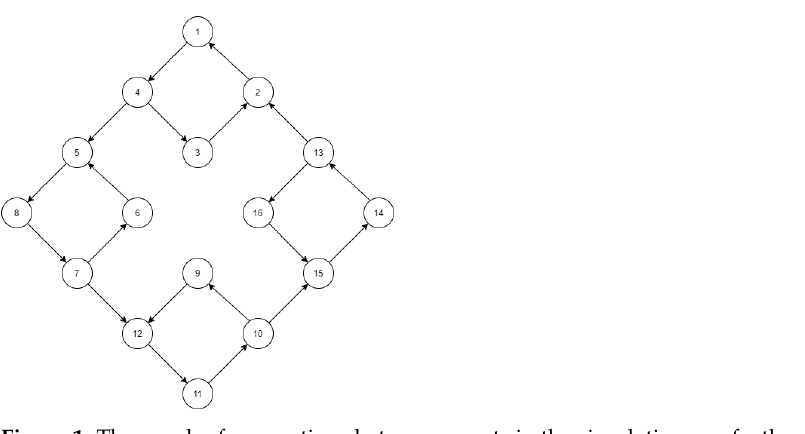
Figure 1. The graph of connections between agents in the simulation; we further associate the four “square” shaped components as clusters, where clusterization emerges due to connectivity.